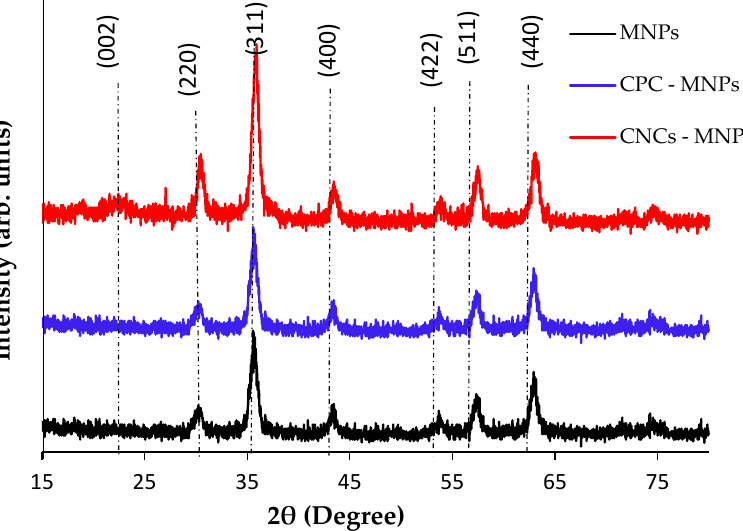
Figure 3. XRD patterns for MNPs, CPC-MNPs, and CNC-MNPs.